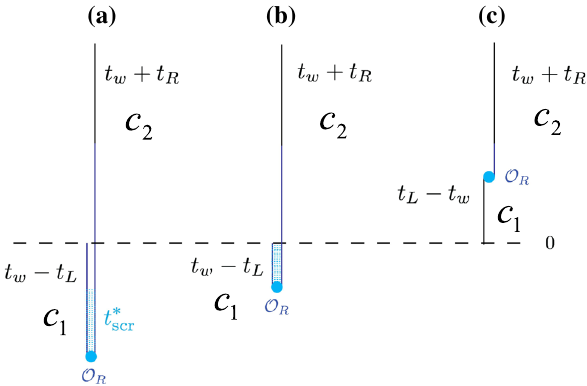
Fig. 7 A representation of the insertion of a perturbed operator O R at the time − t w for the TFD state, in analogy to the construction in figure 25 of [45] as well as figure 6 of [3]